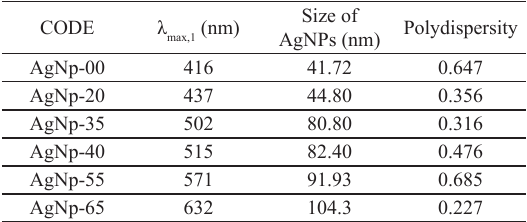
Table 2. Average sizes of some AgNPs obtained from DLS analysis along with the maximum of the main plasmon absorption band (λ ) for each one of them. max,1